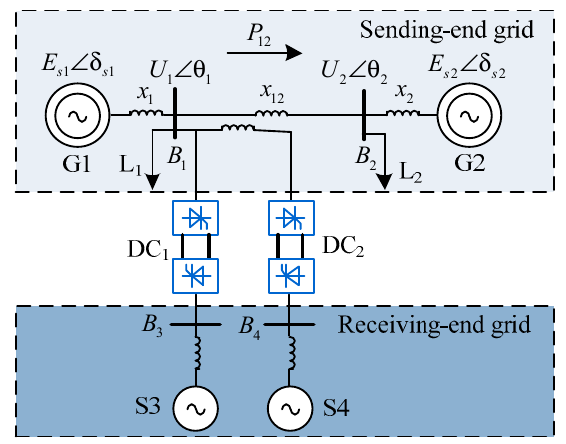
/ DC interconnected